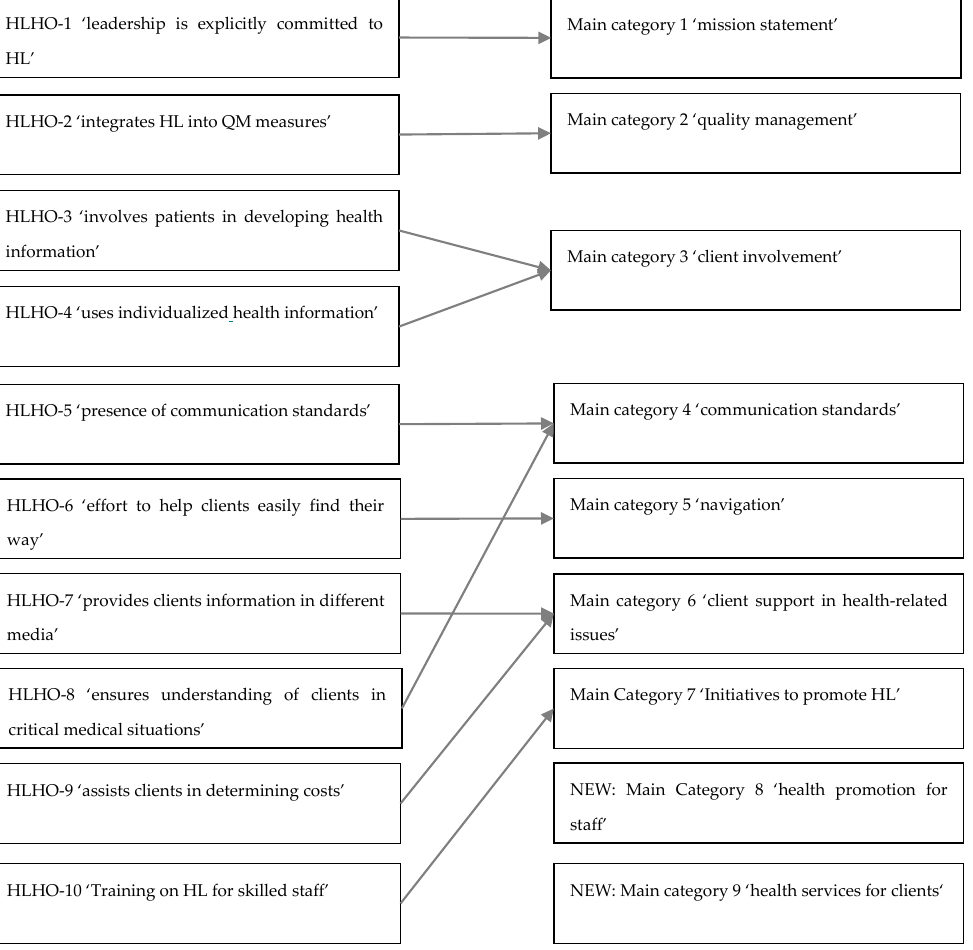
Figure 2. Figure 2. Changes from ‘a priori categories’ (HLHO -10 items) to main categories (quality content analysis).